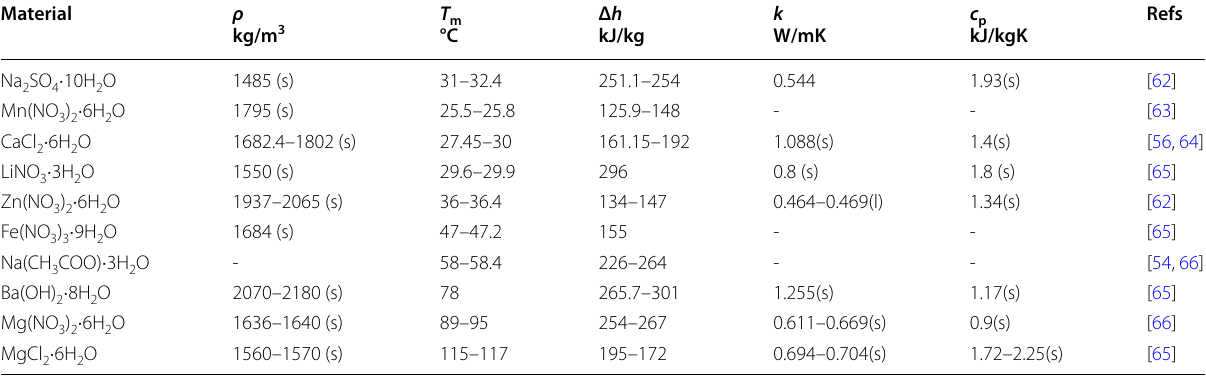
Table 3 Thermophysical properties of selected salt hydrates as PCMs